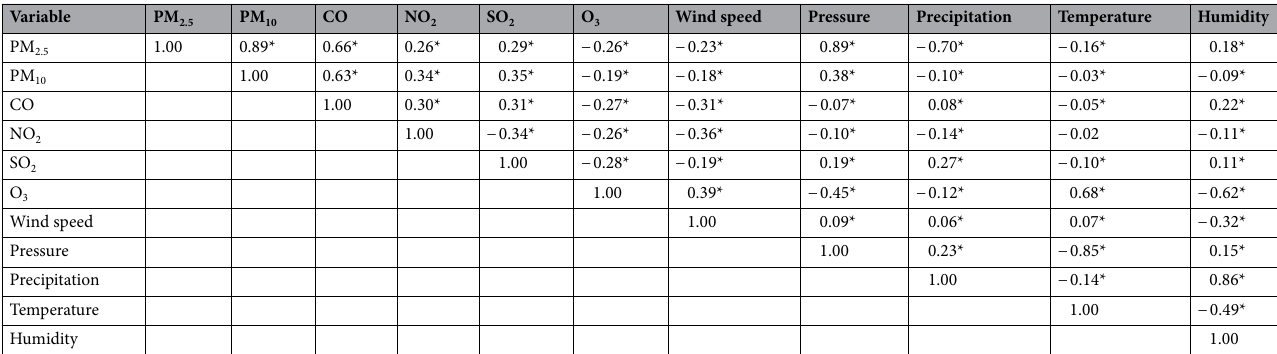
Table 2. Pearson linear correlation coefficients between six types of air pollutant concentrations and meteorological parameters (Band * indicates significant correlation at a significant level of